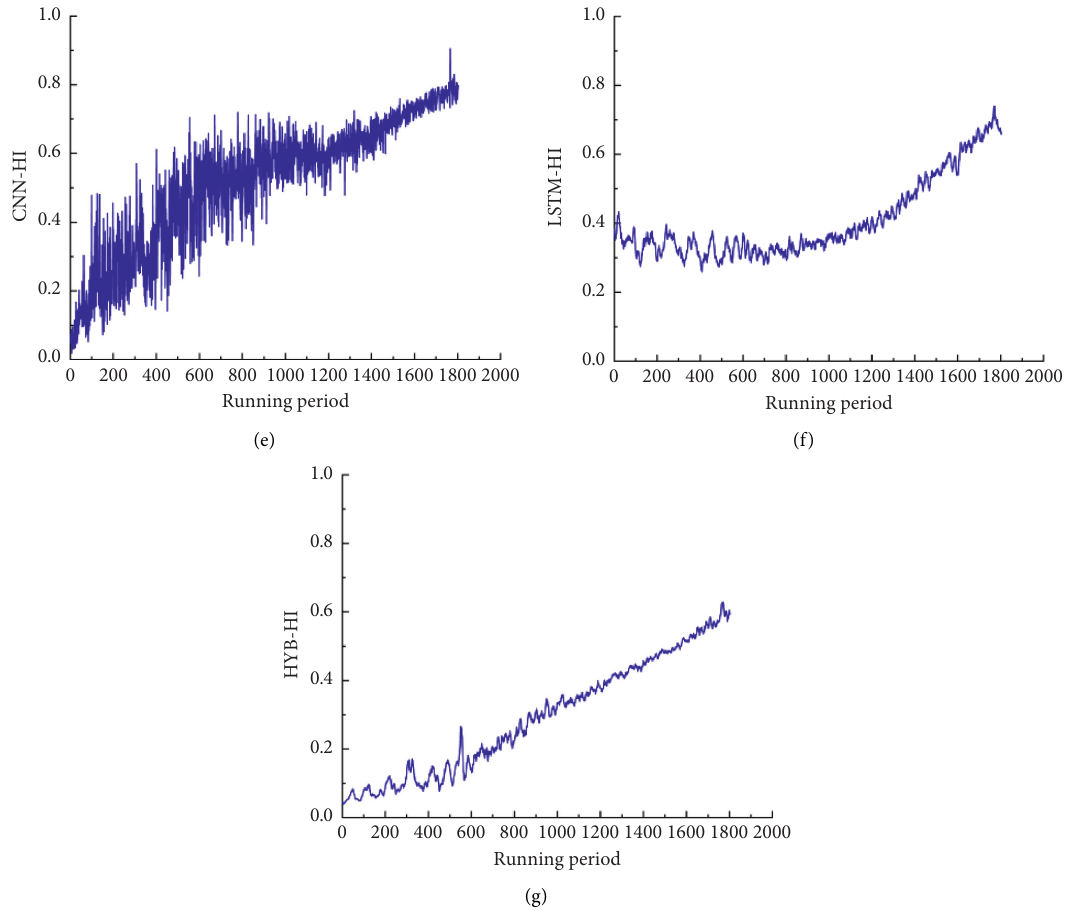
Figure 6: The HI curve constructed by different method. (a) Root-mean-square-based HI. (b) Kurtosis-based HI. (c) Crest-factor-based HI. (d) Peak-peak-based HI. (e) CNN-based HI. (f) LSTM-based HI. (g) Hybrid-structure-based